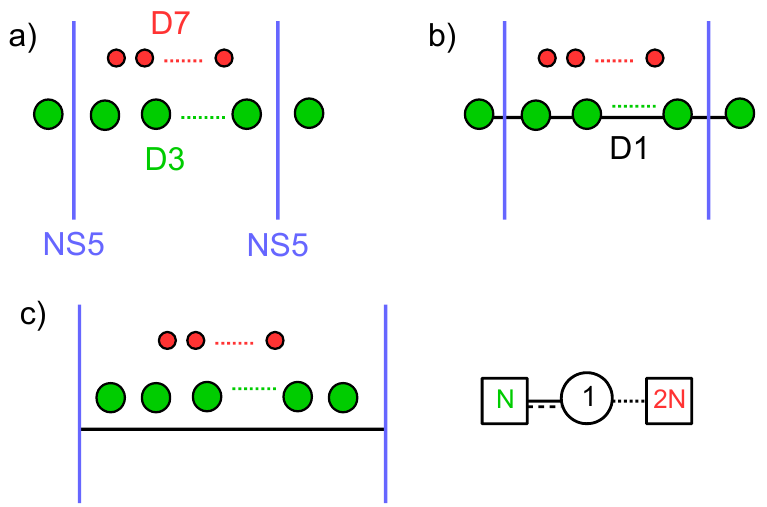
Figure 4 . a) Brane realization of L 1 loop in SU( N ) with 2 N (cid:13)avors. There are N D3s and 2 N D7s. b) Bubbling con(cid:12)guration. c) Same con(cid:12)guration after moving NS5s and ADHM